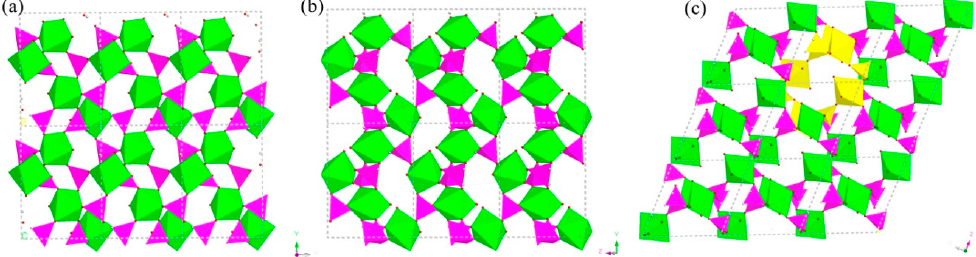
Figure 9. The polyhedron structure of 4 ( a ) six-ring channel in (001) direction. ( b ) Eight-ring channel in (100) direction. ( c ) 10-ring channel in (010) direction. P, pink; In, green; H, white; O, red.